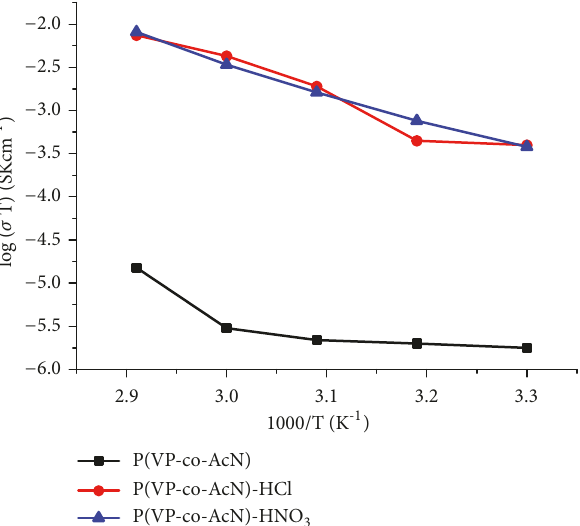
Figure 15: log ( 𝜎 T) versus 1000/T plots for the copolymer and its